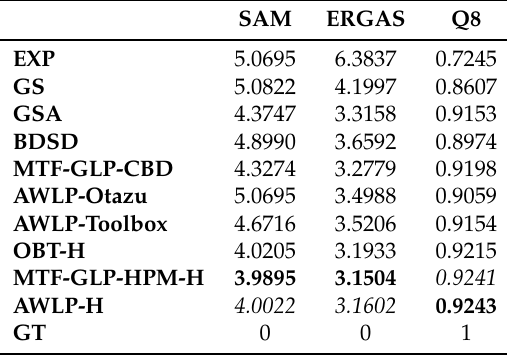
Table 3. Degraded-resolution WorldView-2 Rio dataset: cumulative distortion and quality indexes. Best results in boldface; second best in